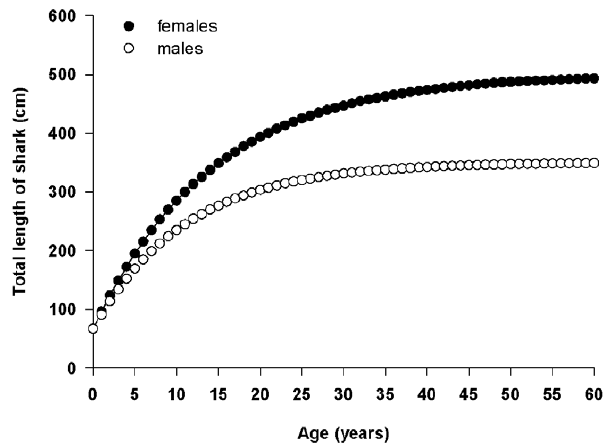
Figure 2. Growth curves of male and female sixgill sharks.